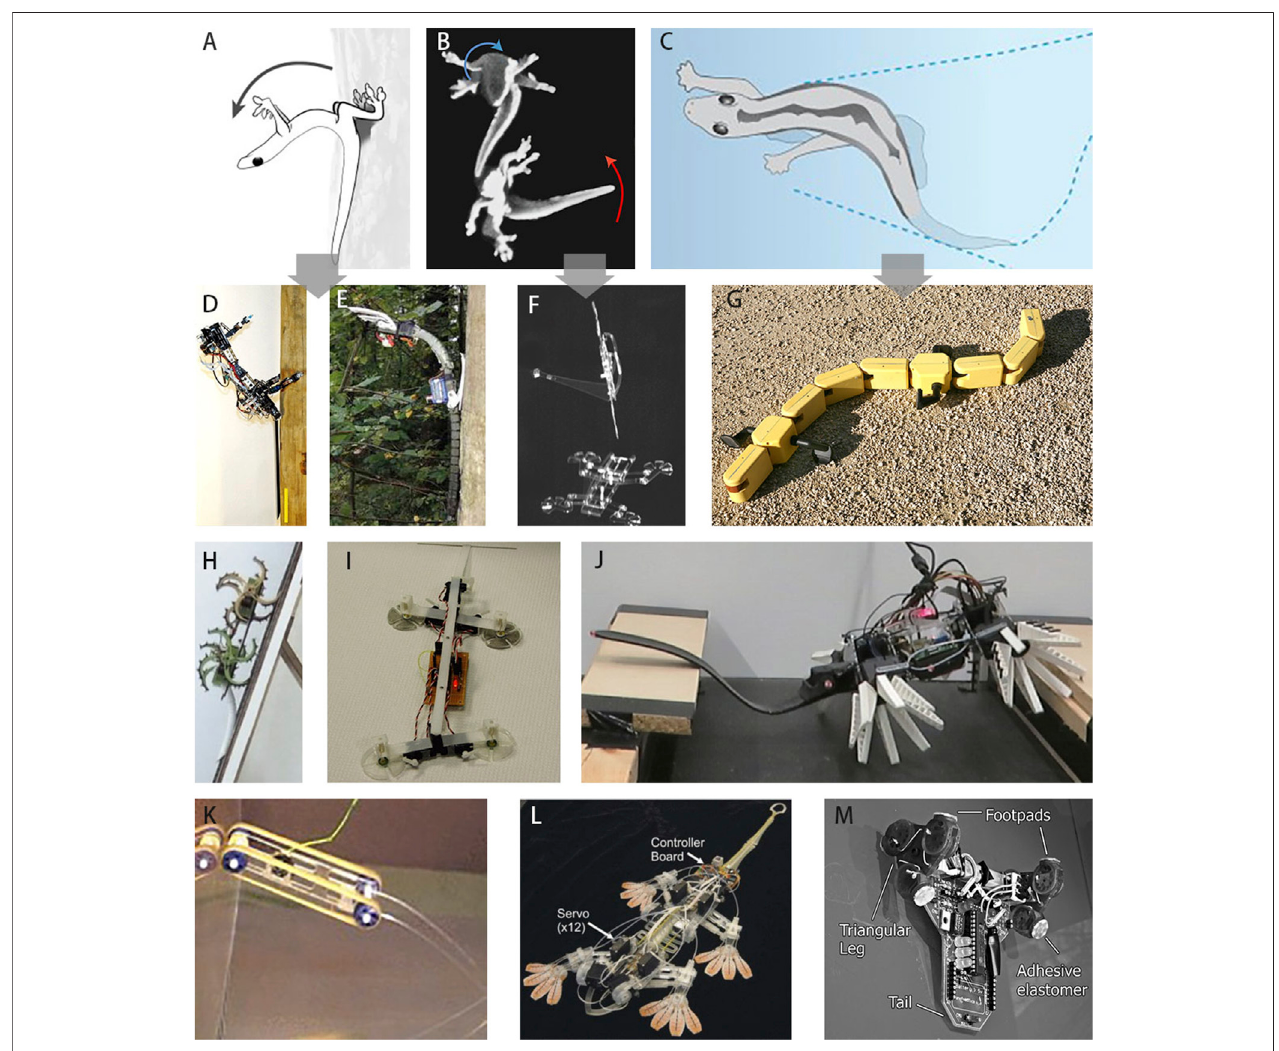
FIGURE1 | A review ofthe various studies and models used to assess the roleof tail inlocomotion. (A) Gecko pressing thetail tip against thewall to avoid slipping during climbing over a slippery gap (Siddall et al. (2021a)). (B) Gecko rotating the tail to achieve air-righting (Jusu fi et al. (2008)). (C) The undulation of the tail assists geckos race across the water (Nirody et al. (2018)). (D) RiSE with an active rigid tail as an emergency fi fth limb to avoid pitch-back (inspired by panel 1A) (Jusu fi et al. (2008)). (E) RiSE with an active soft tail to assist the robot land on a tree (inspired by panel 1A) (Siddall et al. (2021a)). (F) Stickybot with a rotating tail to achieve air- righting(inspiredbypanel1B)(Jusu fi etal.(2010)). (G) SalamandraroboticaII,asalamanderinspiredamphibiousrobotwithamodularrigidtailthatcouldundulatetohelp it swim (inspired by panel 1C) (Figure by A. Ijspeert, courtesy Biorobotics Laboratory, EPFL). (H) The slope climbing robot with a passive soft tail to assist in climbing (Siddalletal.(2021b)). (I) Geckobotwithanactiverigidtailforavoidingpitch-back(Unveretal.(2006)). (J) Compliant fi nraywhegrobotwithanactivesofttailforobstacle crossing (Siddall et al. (2021b)). (K) Tankbot with a passive soft tail for completing plane transition (Unver and Sitti (2009)). (L) Stickybot I with an active tail for avoiding pitch-back(Kimetal.(2007)). (M) Waalbotwitha fi xedrigidtailtoavoidpitch-back(MurphyandSitti(2007)).Notethatthe fi rst-row animal fi gures (A,B,C) correspondto the second-row robot fi gures (D,E,F,G) . All fi gures are reproduced with permission from respective journals.